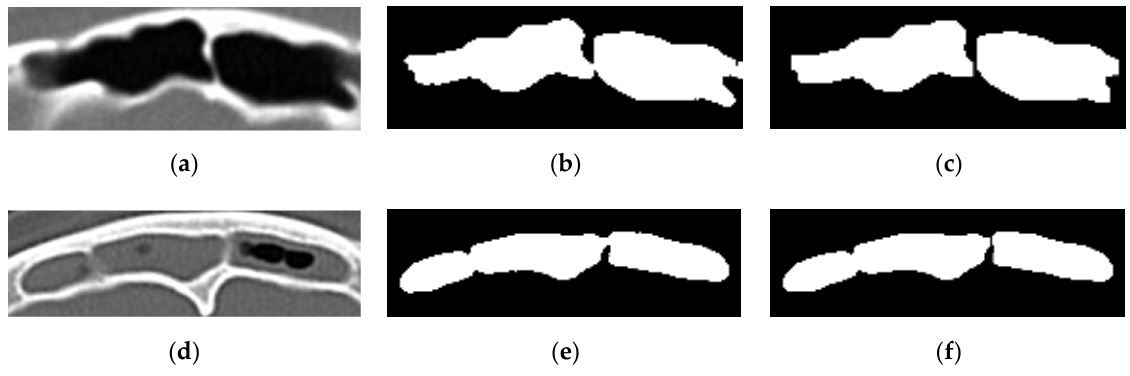
Figure 21. Schematic diagram of frontal sinus segmented by morphology. ( a ) Input image; ( b ) Pre- dicted image; ( c ) Morphology processed im-age; ( d ) Input image; ( e ) Predicted image; ( f ) Morphology processed image.